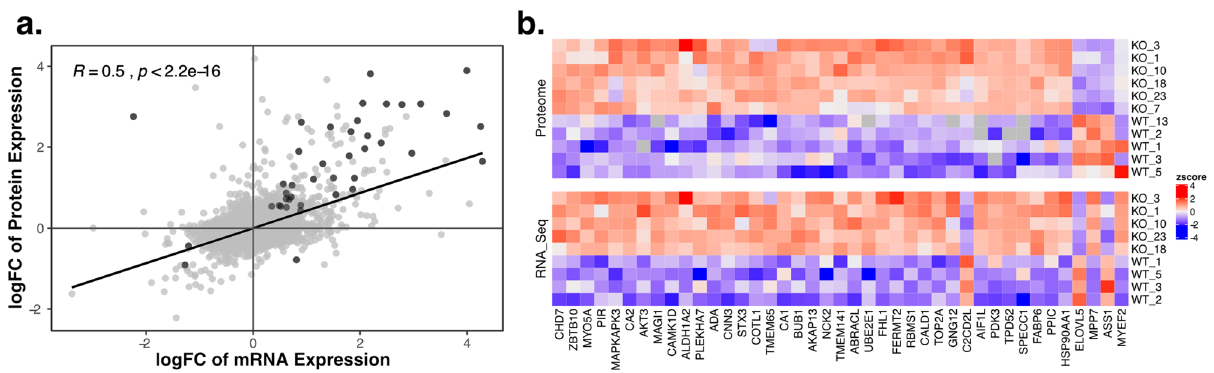
Figure 6. Upregulation of EZH2 target genes. (a) Correlation of protein and mRNA expression. Dark grey points representing genes differentially expressed in both measures (adj.P < 0.05). Pearson’s correlation. (b) Heatmap of the 41 genes differentially expressed (adj.P < 0.05) between EZH2 −/− and wild type clones, in both protein and mRNA. The colour gradient from red to blue represents high to low expression of genes. White indicates no